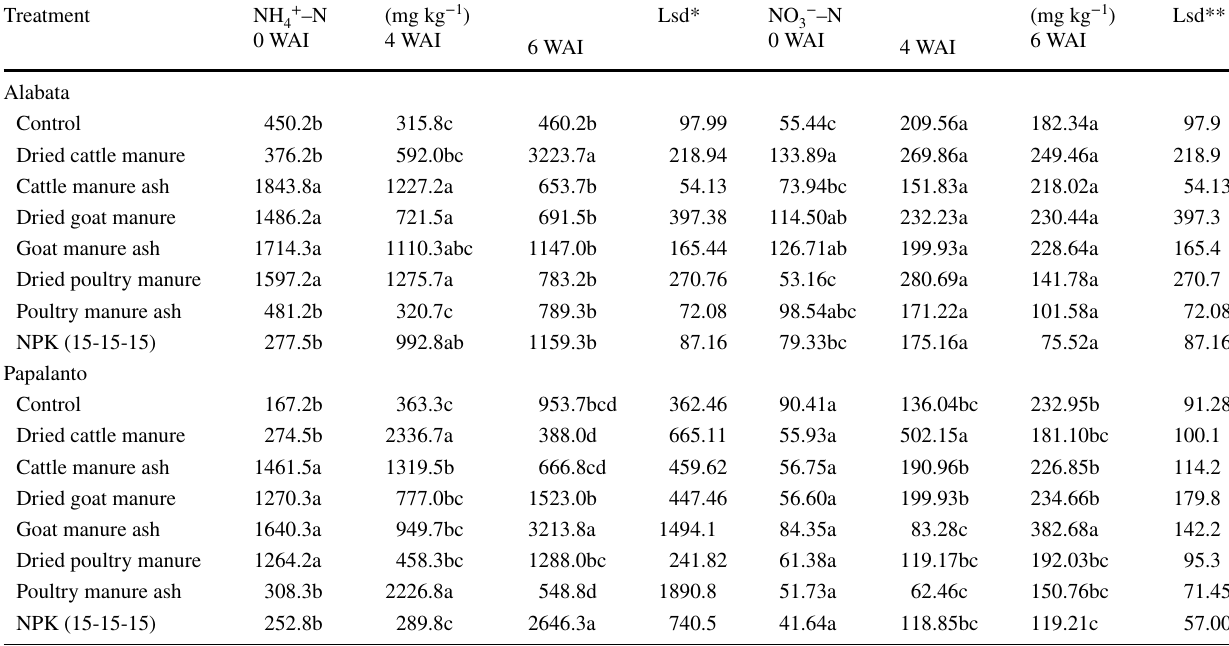
Table 6 Effect of amendments and time on Soil ammonium nitrogen and nitrate nitrogen of Alabata and Papalanto in screen-house (cycle 2)